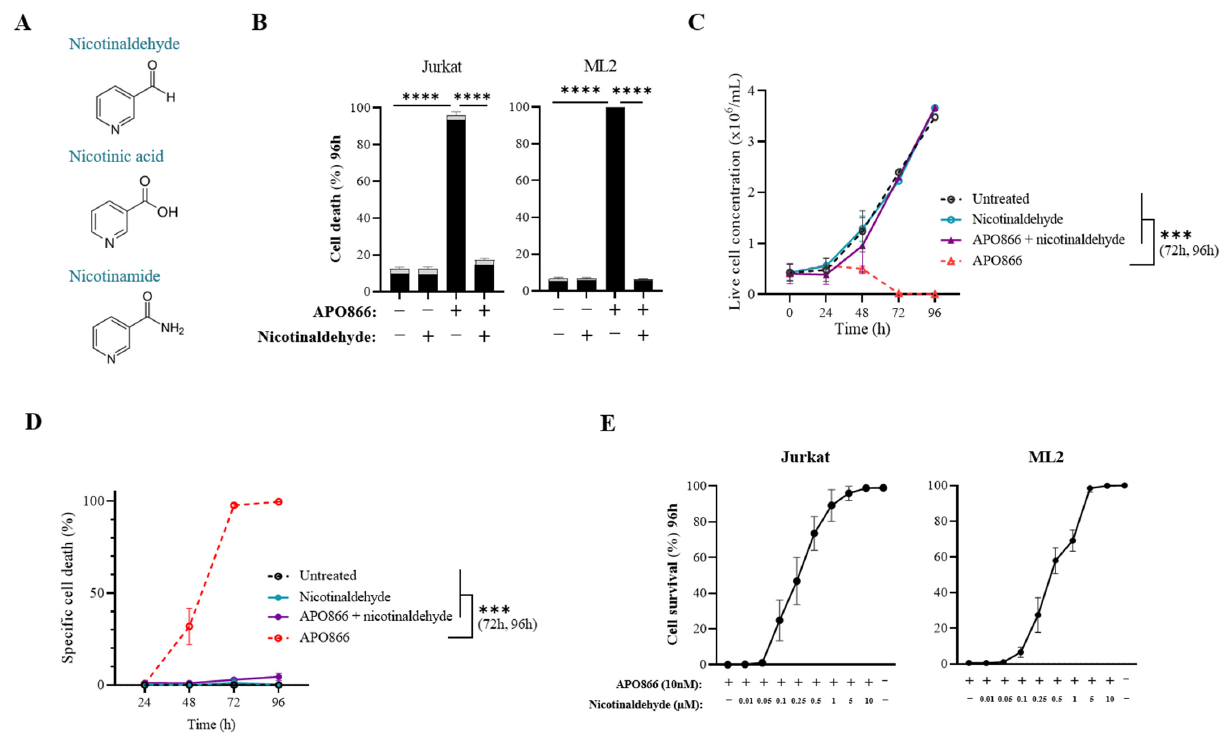
Figure 1. Nicotinaldehyde supplementation abrogates APO866 cytotoxicity in leukemia cells. ( A ) Chemical structures of nicotinaldehyde (3-pyridinecarboxaldehyde) and of NAD precursors nicotinic acid and nicotinamide. ( B ) Cell death of Jurkat and ML2 cells at 96 h of APO866 (10 nM) treatment with or without 10 µ M of nicotinaldehyde supplementation (black box = 7AAD + , late apoptosis and necrosis. Grey box = annexin V + 7AAD − , early apoptosis). ( C ) Time course cell growth evaluated from live cell number and ( D ) time course cell death rate of Jurkat cells treated with APO866 (10 nM) for 96 h, with or without 10 μ M nicotinaldehyde supplementation. ( E ) Cell survival of Jurkat and ML2 cells treated with APO866 (at 10 nM) and nicotinaldehyde at concentrations ranging from 0.01 to 10 μ M for 96 h. Error bars represent SD of at least 3 independent replicates. *** P < 0.001, **** P < 0.0001.